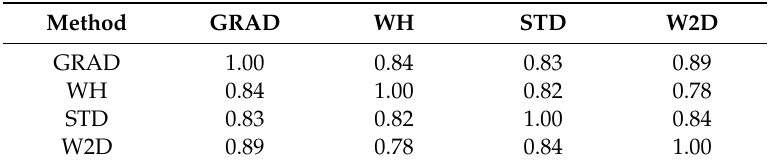
Table 6. Inter-comparison of the ML heights (m) determined by di ff erent methods for summer sunny days of